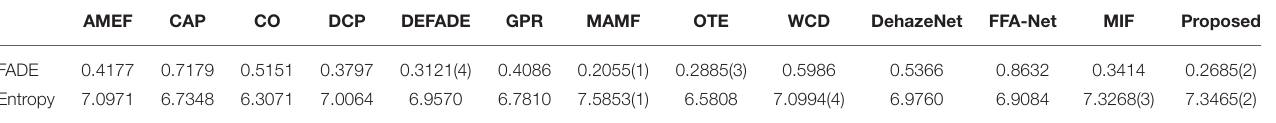
AMEF Proposed FADE Entropy